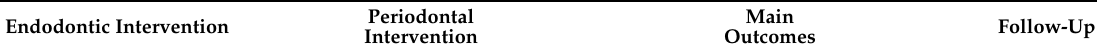
Table 1. Characteristics of the evaluated